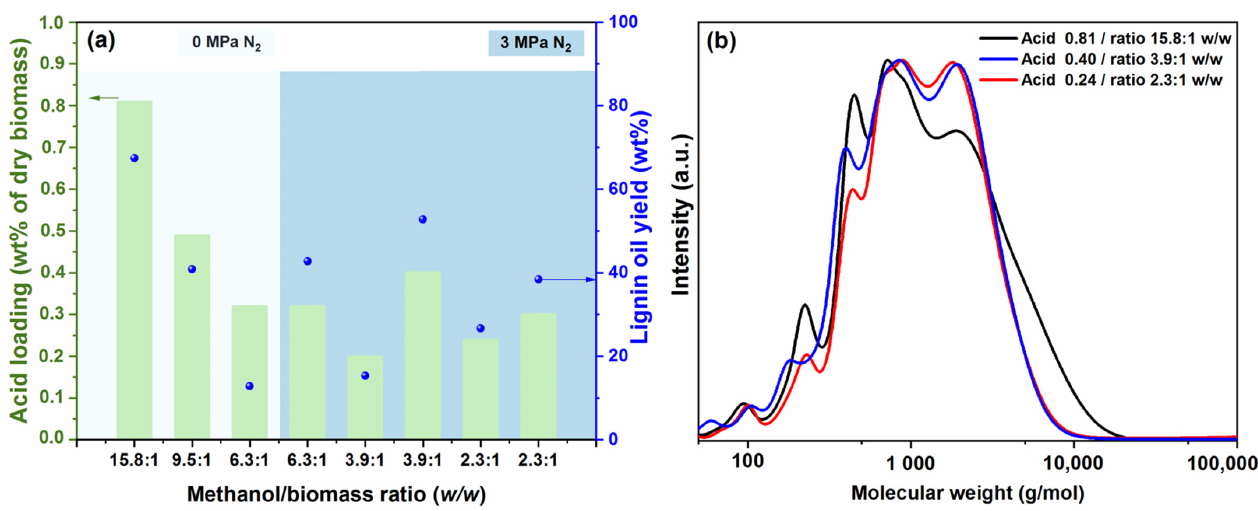
Figure 3. Acid solvolysis of birchwood at 180 °C for 2 h: ( a ) influence of acid loading and methanol/biomass ratio on the lignin oil yield; ( b ) molecular weight distribution of lignin fractions from entries 3,10,11 (Table 1).